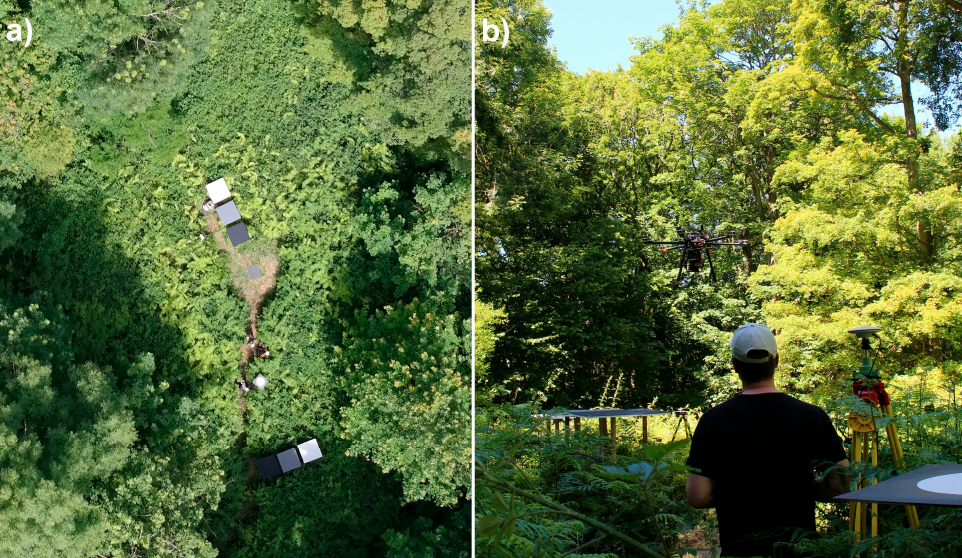
Figure 5. ( a ) An aerial image of the take-off and landing site. The reference panels BC, GC and GP in direct sunlight and in shadow are visible in image. ( b ) An image of the UAV landing site. The proximity of trees to the reference panels is evident in this image.